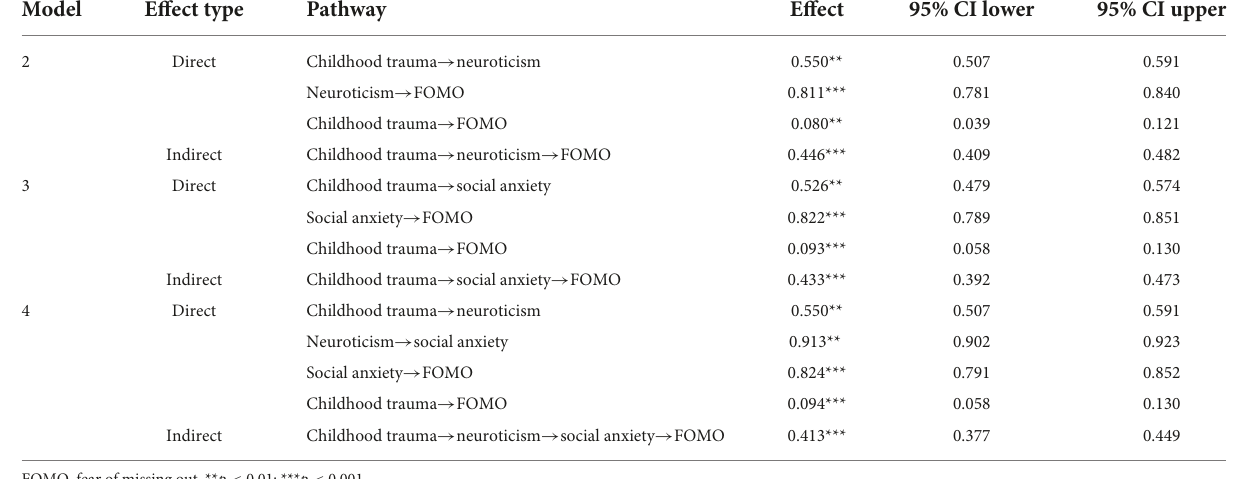
TABLE 3 Pathways of the mediation model using bootstrapping.